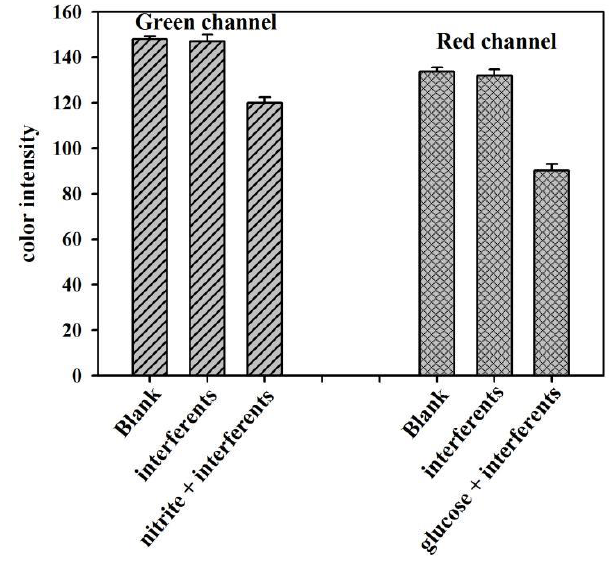
Figure 10. Specificity of the developed μPADs. The concentration of nitrite or glucose is 0.5 mM and the concentrations of the other interferents are all 50 mM.